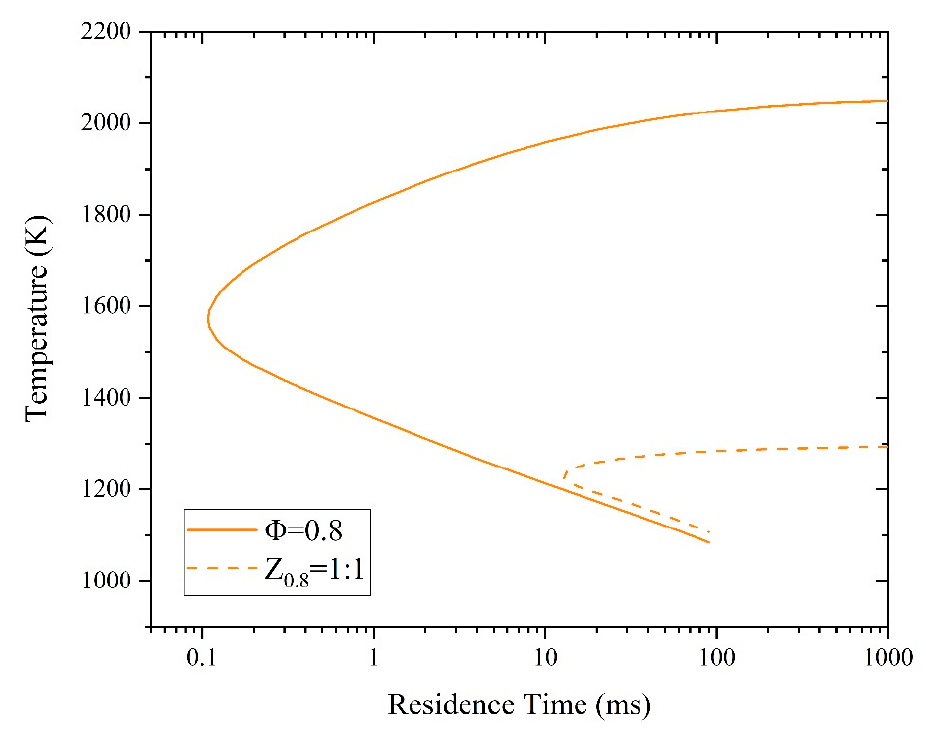
Figure 9. Comparison of C-curves of n -pentane at an equivalence ratio of 0.8 and air–light hydrocarbon mixing gas at a mixing degree of 1.